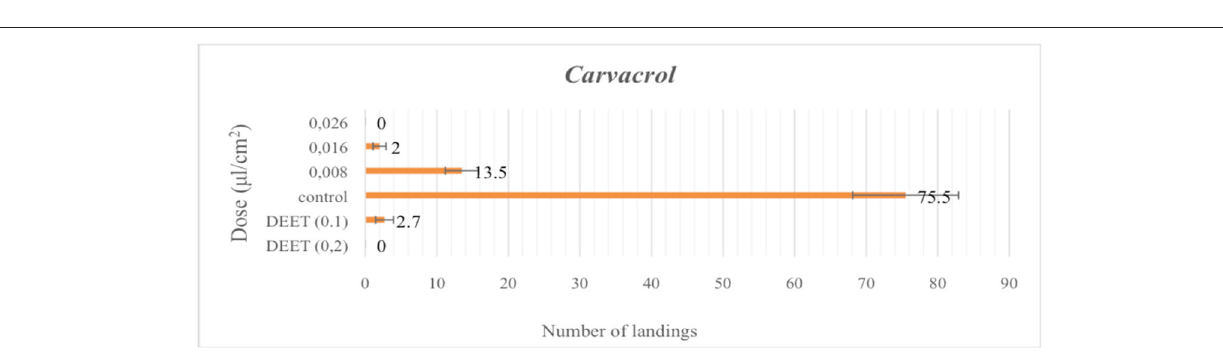
FIGURE 2 | Repellent activity of carvacrol as mean number of landings ( ± SE) determined under laboratory conditions. Doses are expressed as µ L/cm. DEET was used as the positive control in two doses, 0.1 and 0.2 µ lcm − 2 for 5min. (Means in a column followed by the same letter are not significantly different ( P ≥ 0.05), Mann–Whitney U -test).